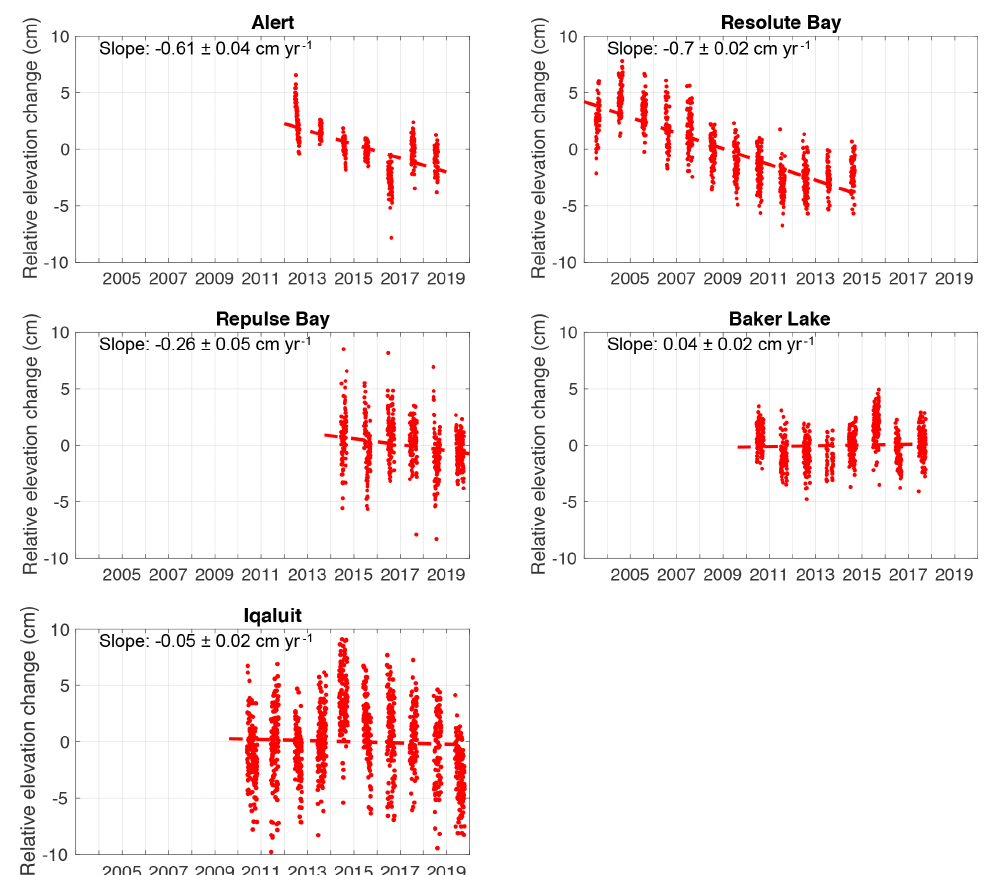
Figure 5. Time series and the best-linear-fit dashed lines of surface elevation changes in thaw seasons at the five CACS sites. For clarity, we do not show the error bars. For the y axis, “relative” means that the presented elevation changes are referenced to the mean value of the entire records at each